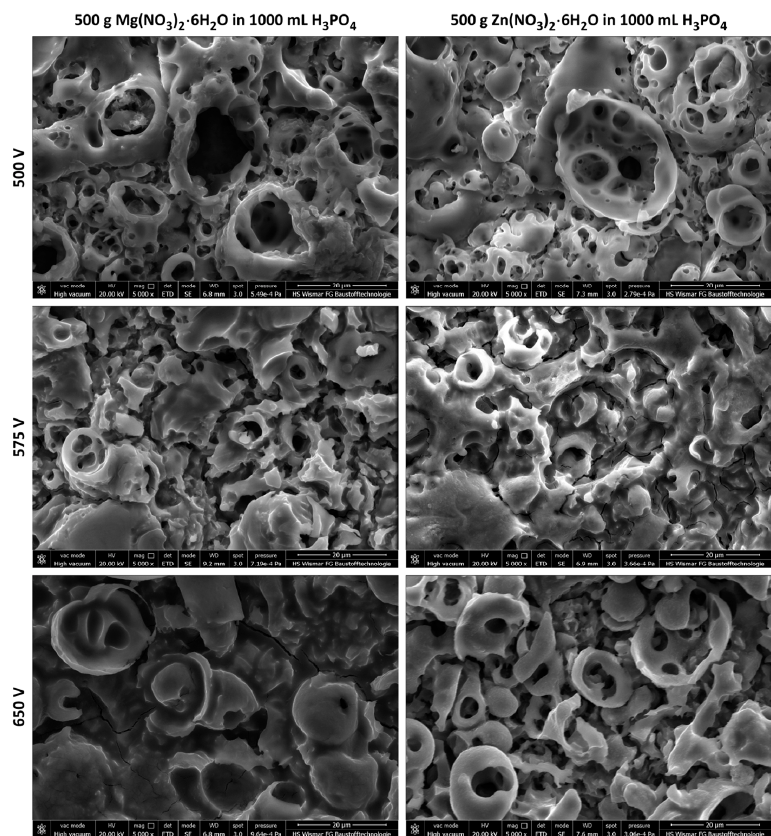
Figure 3. SEM micrographs of coatings formed on CP Titanium Grade 2 after PEO treatment at voltages of 500 V, 575 V, 650 V in H 3 PO 4 electrolyte with addition of 500 g·L − 1 Mg(NO 3 ) 2 ·6H 2 O or 500 g · L − 1 Zn(NO 3 ) 2 · 6H 2 O. Magnification: 5000 times.